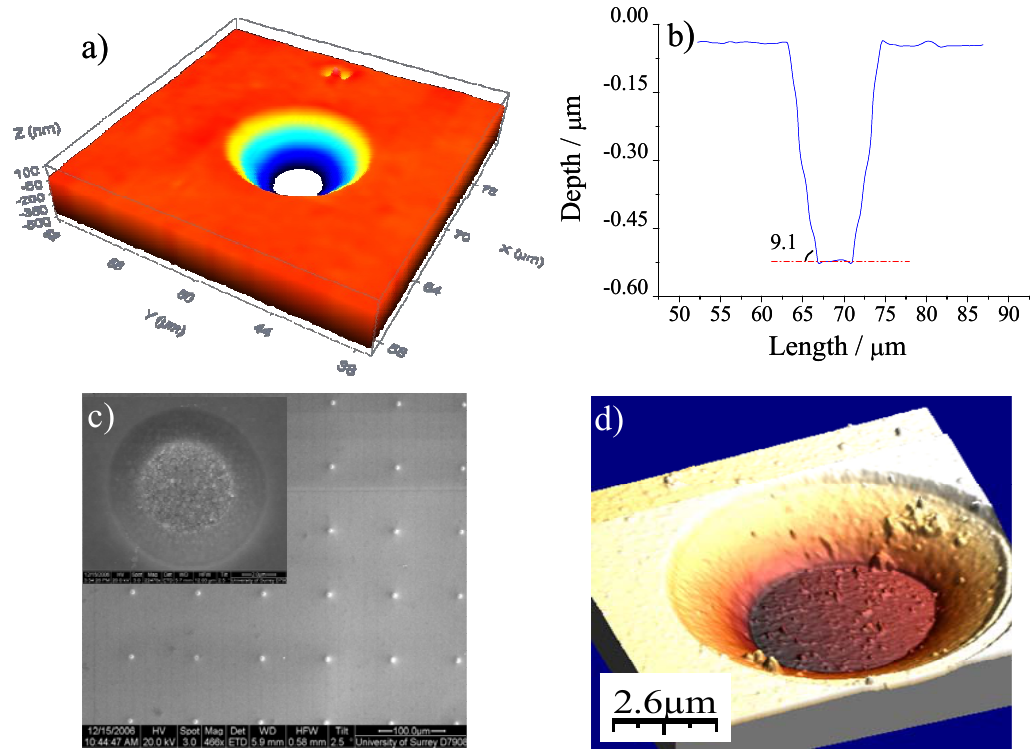
Figure 6. Images of a UMEA (5 µm disk diameter and 100 µm inter-electrode distance) unit obtained using a) a confocal imaging profiler; b) profile extracted from image in a). c) SEM, d)